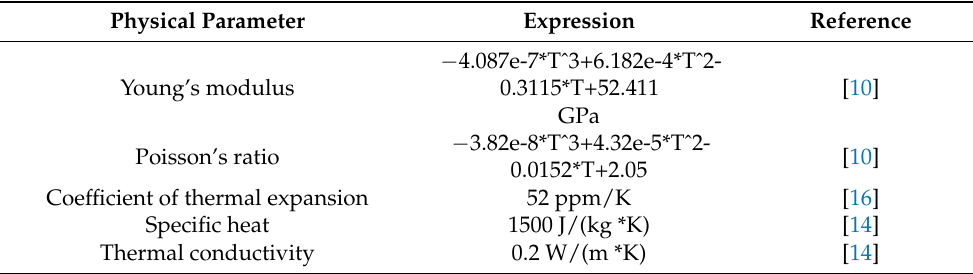
Table 1. Physical parameters of SU-8 (Young’s modulus and Poisson’s ratio are cubic polynomially fitted using the data in reference [10] (the SU-8 in this reference is not post-baked, so the Young’s modulus is relatively low)).